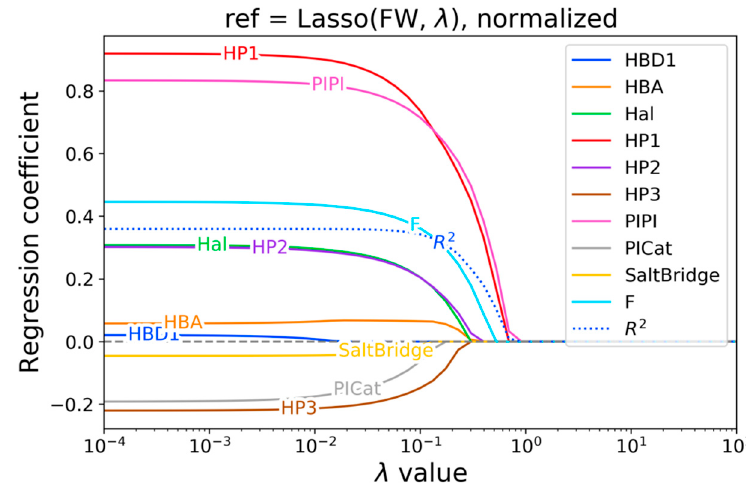
Figure 1. Statistical performance ( R 2 ) and the values of the coefficients of the Lasso model, linking